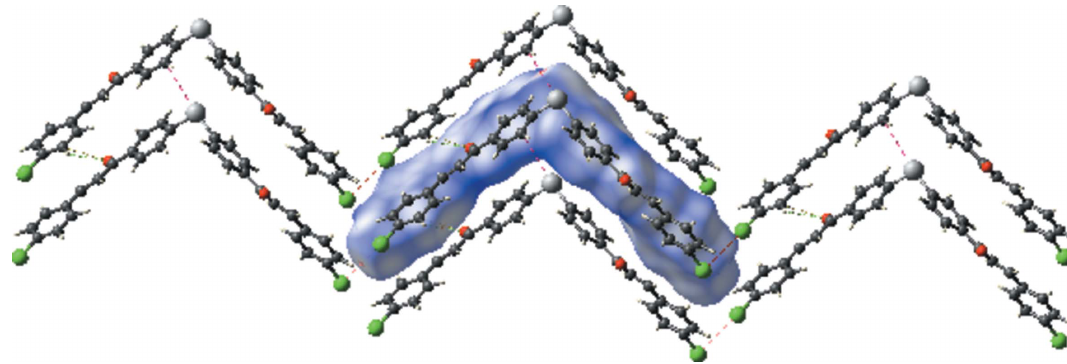
Figure 5 Hirshfeld surface mapped over d norm to visualize some of the short intermolecular contacts in the crystal (see Table